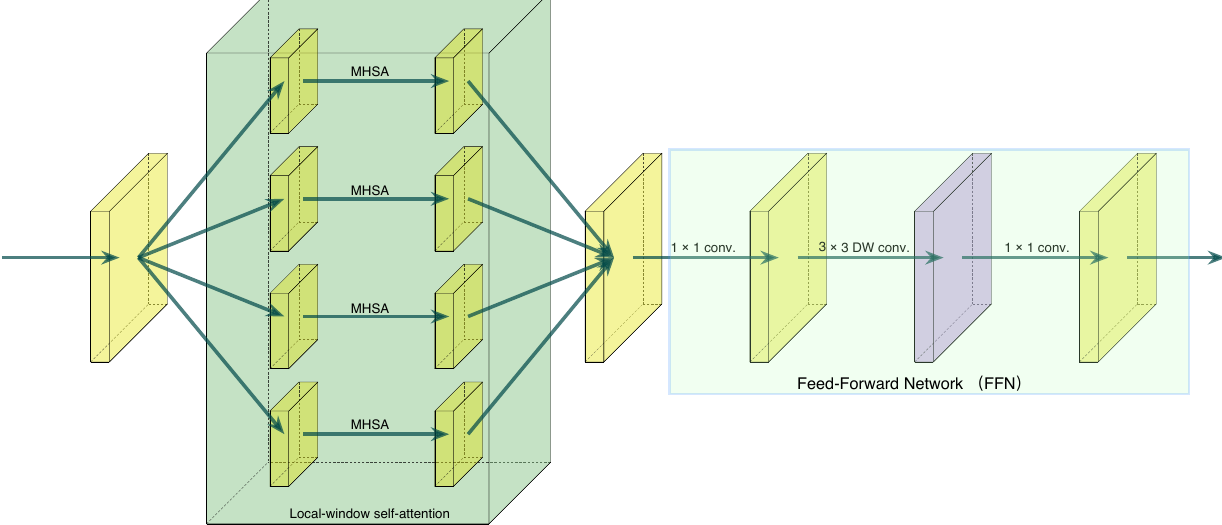
Figure 2. Illustrating the structure of the HRFormer